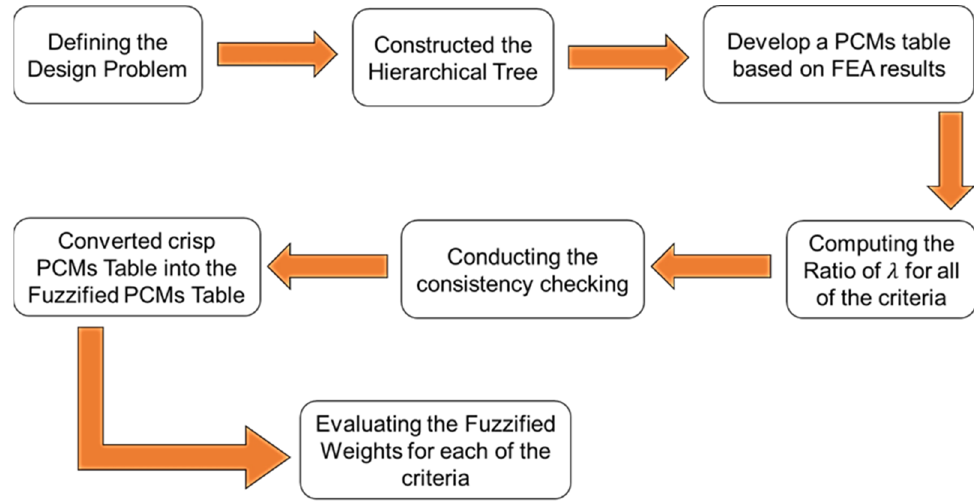
Figure 7. The main steps to determine the fuzzified weights for each criterion using the F-AHP